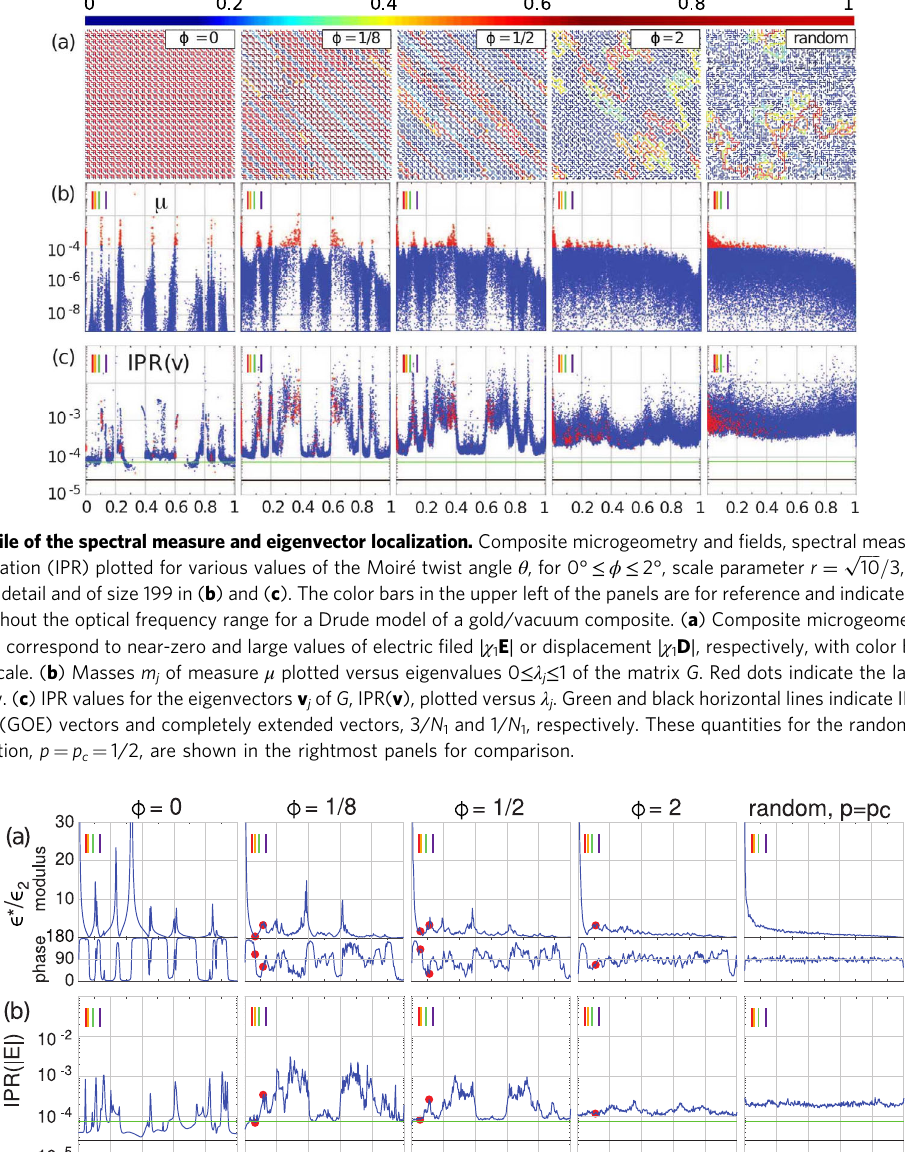
Fig. 4 Frequency dependence of dielectric pro fi le and fi eld localization. Relative effective complex permittivity ϵ * / ϵ 2 and inverse participation ratio (IPR) of the modulus of the electric fi eld, ∣ χ 1 E ∣ , normalized to unity, IPR( E ), plotted versus 0 (cid:8) Re s (cid:8) 1 for Im s ¼ 0 : 001 and various values of the Moiré twist angle θ and ffiffiffiffiffi p = 3, for change in twist angle 0° ≤ ϕ ≤ 2°. The color bars in the upper left of the panels are for reference and indicate Re s ð ω Þ for the optical frequency r ¼ 10 range for impedances corresponding to the Drude model for a gold/vacuum composite. ( a ) Amplitude and phase of ϵ * / ϵ 2 . ( b ) IPR( E ) or equivalently IPR( D ). These quantities for the random percolation model at the percolation transition, p = p c = 1/2, are shown in the rightmost panels for comparison. The red dots in ( a ) and ( b ) identify values of dependant variable Re s used in Fig. 2b: for ϕ = 1/8, Re s ¼ 0 : 063 ; 0 : 115, for ϕ = 1/2, Re s ¼ 0 : 055 ; 0 : 111, and for ϕ = 2, Re s ¼ 0 :